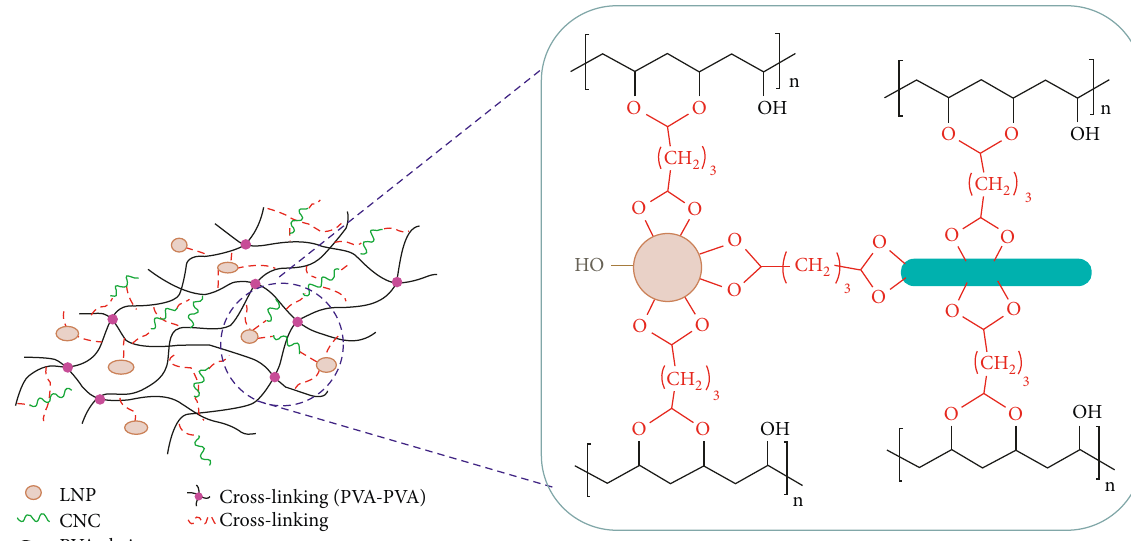
Figure 4: The proposed cross-linking reaction of polyvinyl alcohol, cellulose nano cellulose, and lignin nanoparticles uses glutaraldehyde as a cross-linker [158] (Copyright @ 2020 MDPI under CC by